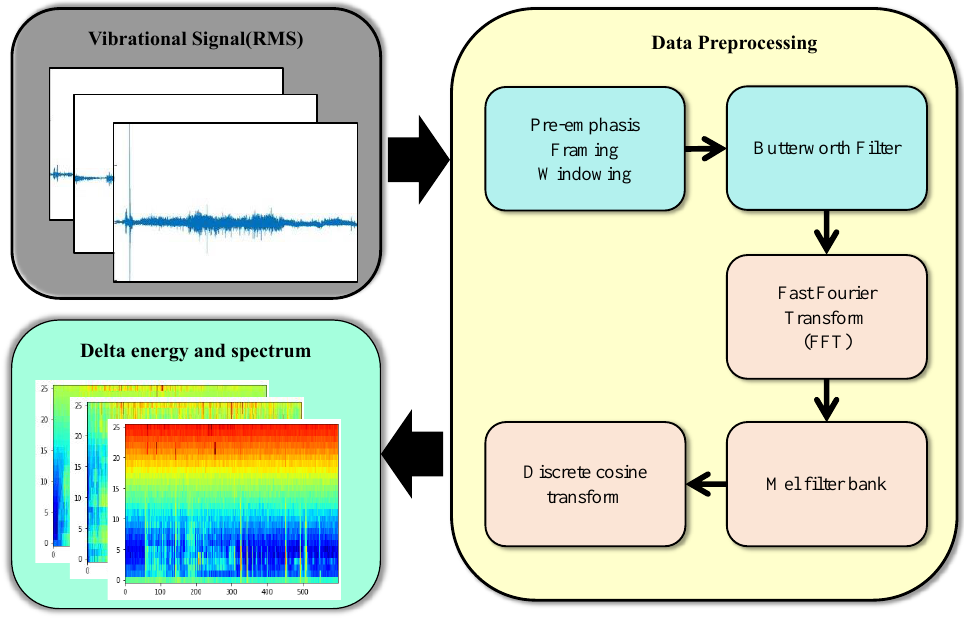
Figure 3. Data preprocessing procedure.